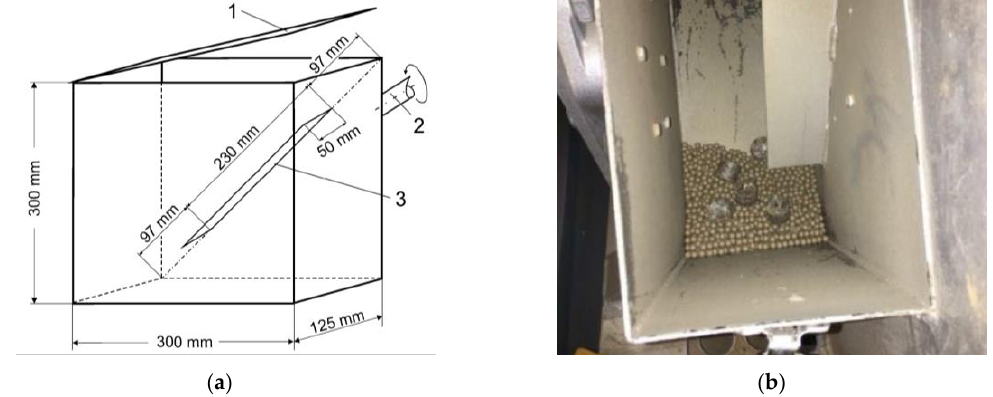
Figure 5. Mechanical durability machine: ( a ) measurement box schematic [53] and ( b ) image of samples immersed in ABS (acrylonitrile butadiene styrene) balls.